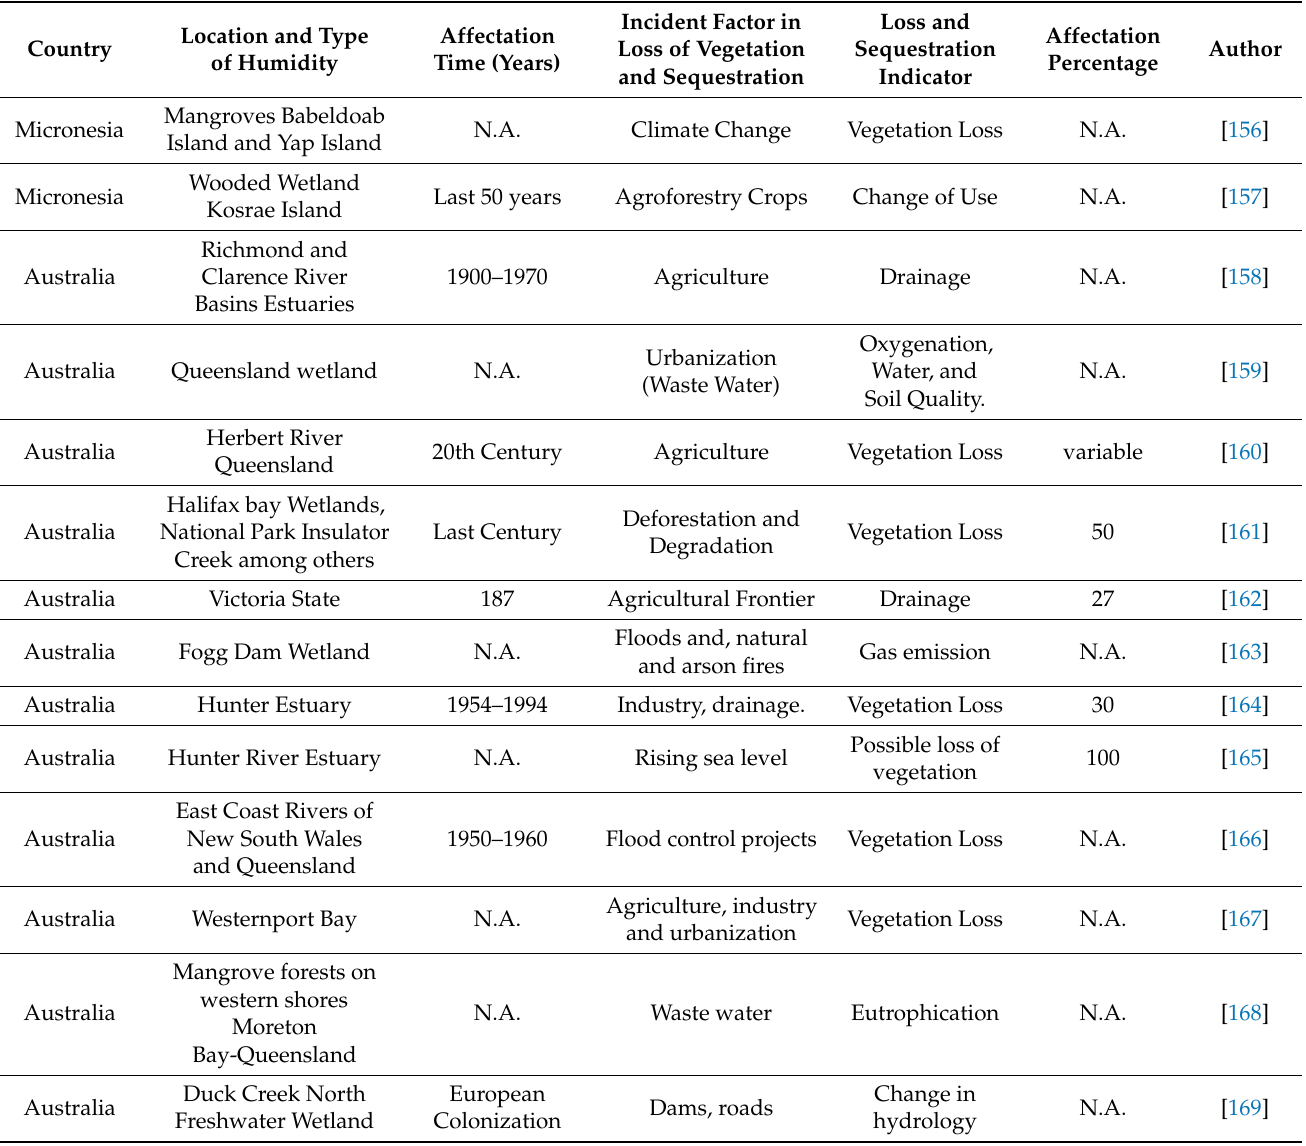
Table 5. Data from the Oceania/Australia continent on wetlands in coastal, marine, and continental zones (n =